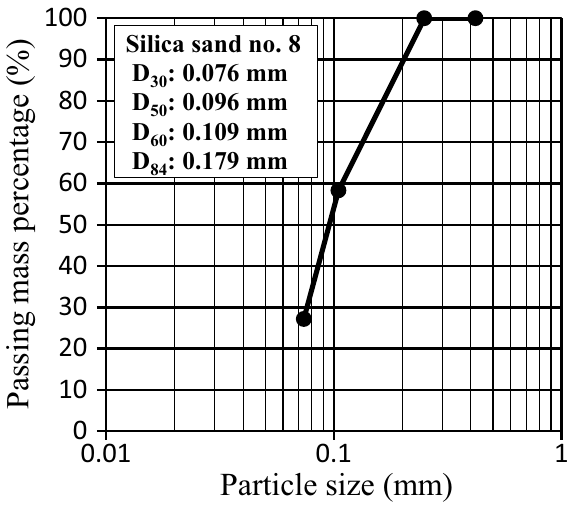
Figure 3. Particle size distribution used in experiment.